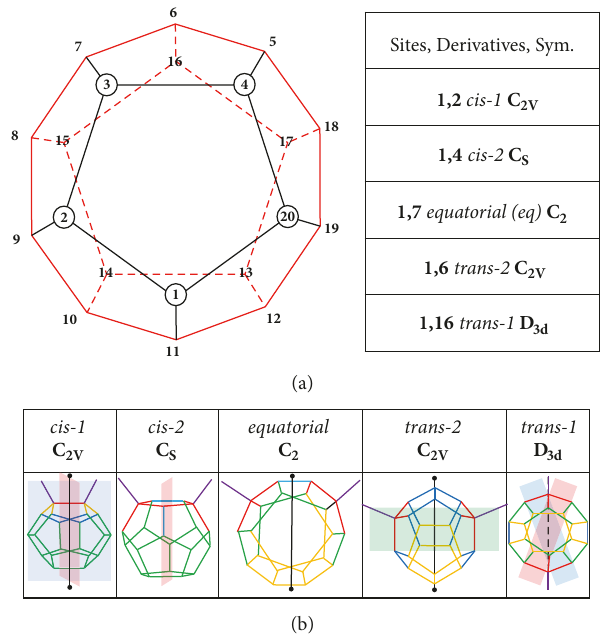
Figure 1: (a) The dodecahedrane and its numbering system (hydrogen atoms deleted for clarity). (b) The dimethyl substituted dodecahedrane derivatives C 20 H 18 (CH 3 ) 2